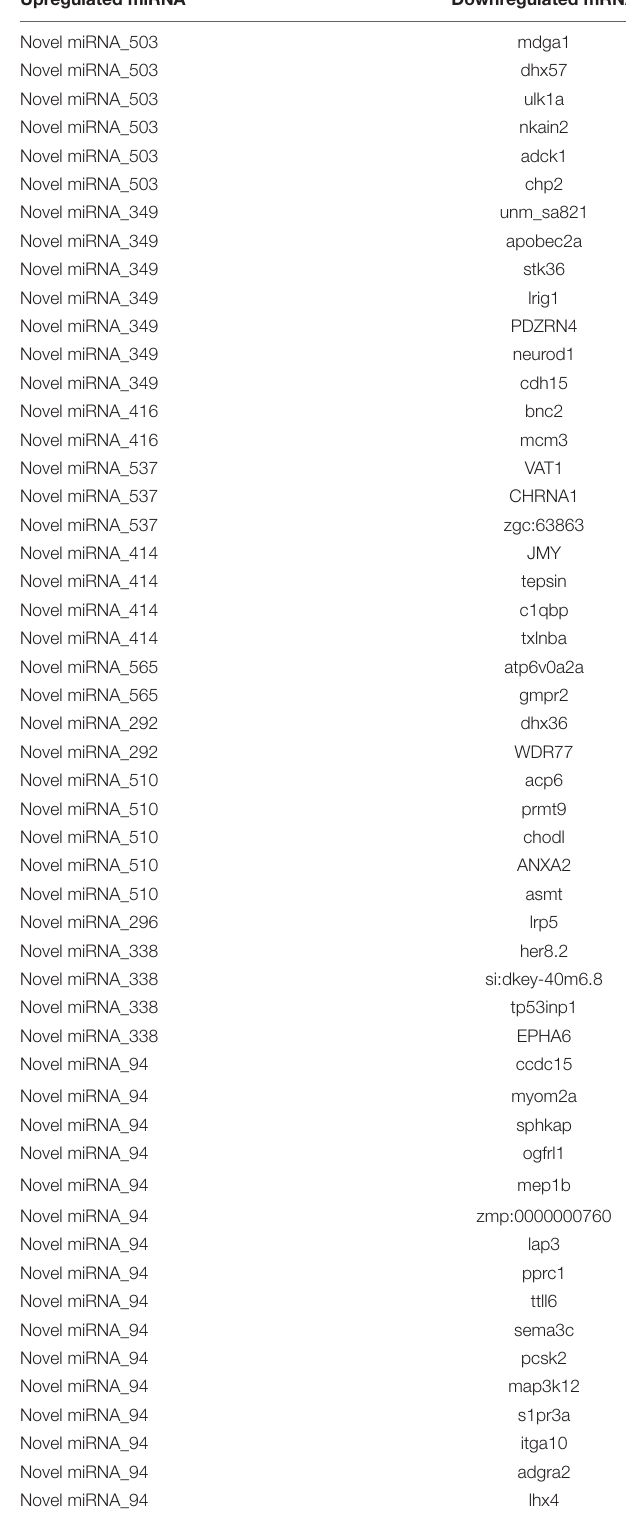
TABLE 4 | Hypoxia-induced downregulated miRNA-upregulated mRNA pairs in medaka embryos. Downregulated miRNA